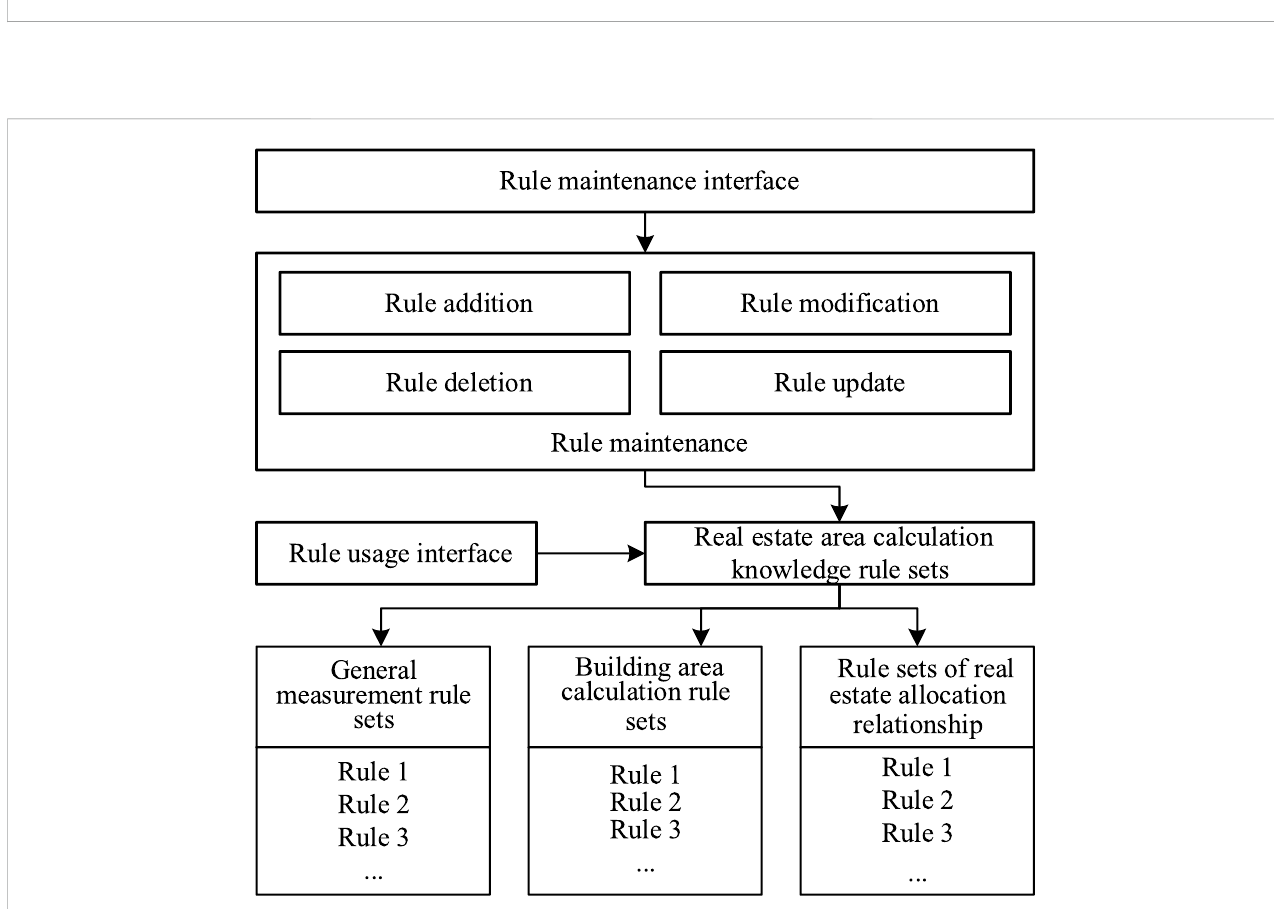
FIGURE 4 Rules for calculating the property area of real estate